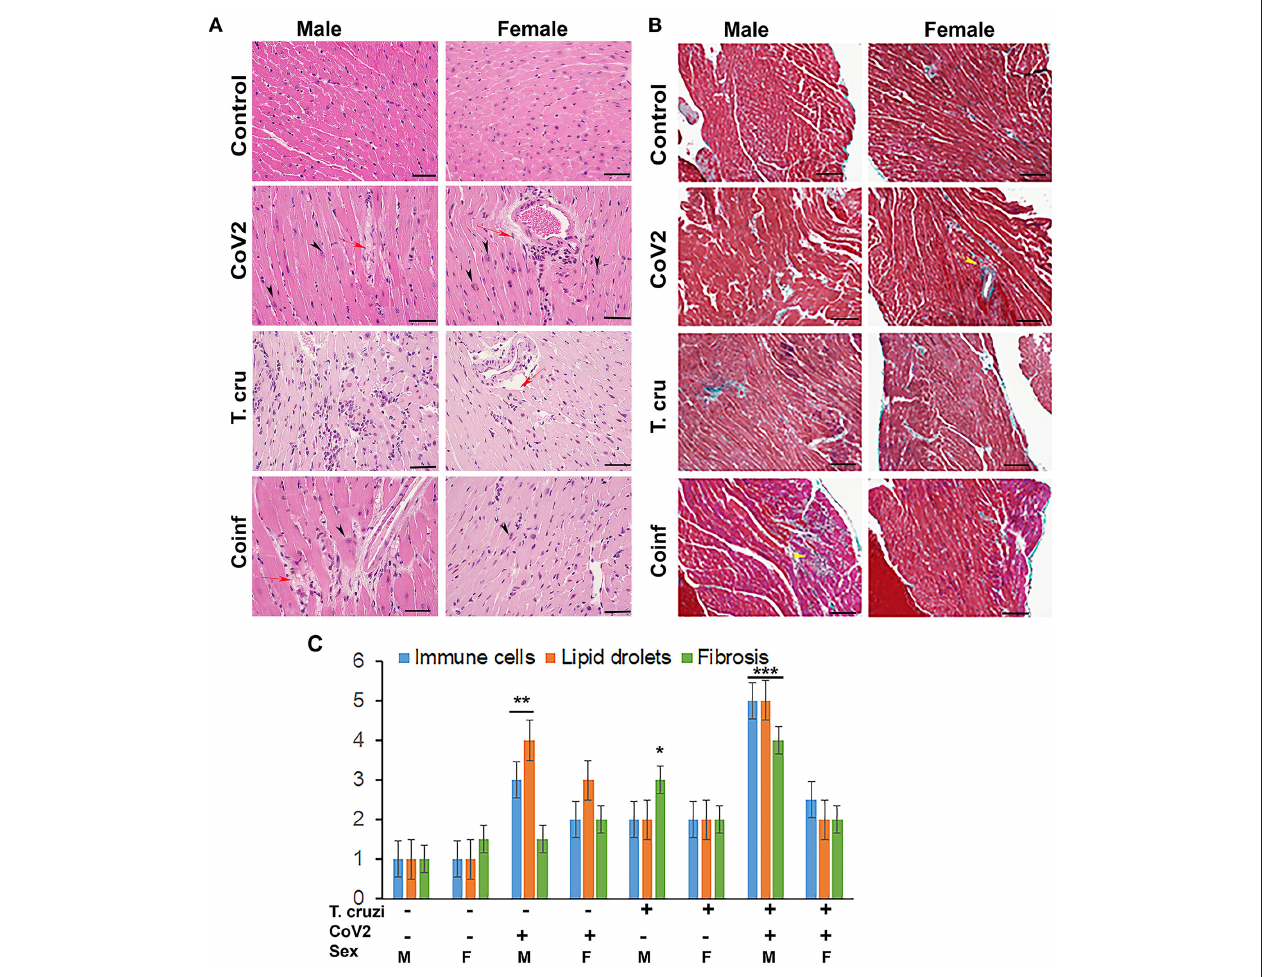
FIGURE 3 | Histology of the myocardium of uninfected, CoV2 infected, T. cruzi infected, and coinfected huACE2 mice ( n = 4/sex, a minimum of five images/section were analyzed). (A) H&E stained sections of left ventricles showing the accumulation of lipid droplets in the capillaries (red arrow) and presence of enlarged cardiomyocyte nuclei (black arrowhead) in infected mice (20x magnification). (B) Masson-trichrome stained sections of right ventricles showing fibrosis (blue and purple) and the presence of immune cells (yellow arrows) in the right ventricles (RV) of infected/coinfected mice (20x magnification; bar – 100 µ m) (Additional images are shown in Supplementary Figures 2, 3 ). (C) Histological grading of heart sections showing the levels of immune infiltrates, lipid droplet accumulation, and fibrosis among CoV2 infected, T. cruzi infected, and coinfected mice compared to uninfected mice in both sexes. The error bars represent standard error of the